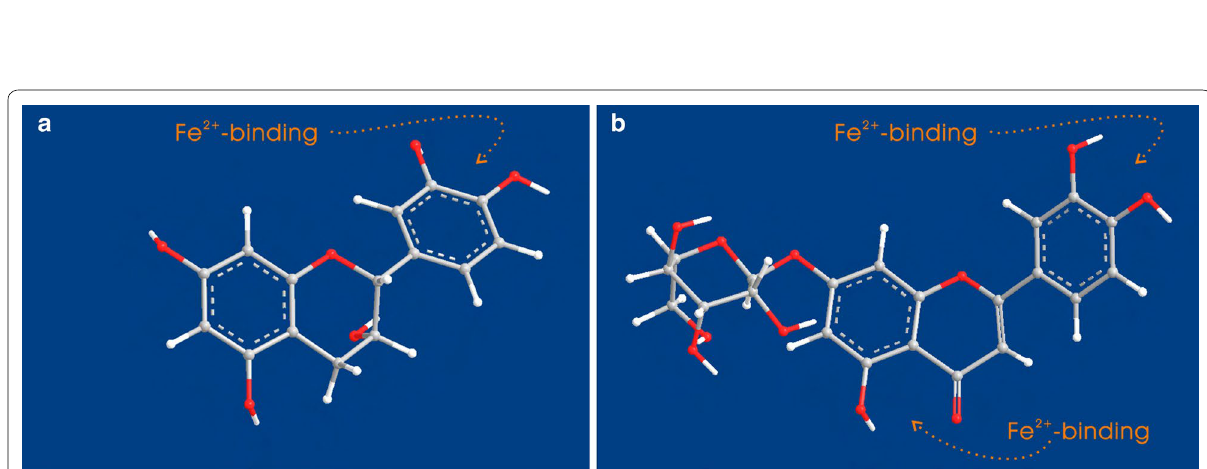
Fig. 5 The preferential conformation-based, ball-stick models of epicatechin ( a ) and luteolin-7- O - β -D-glucoside ( b